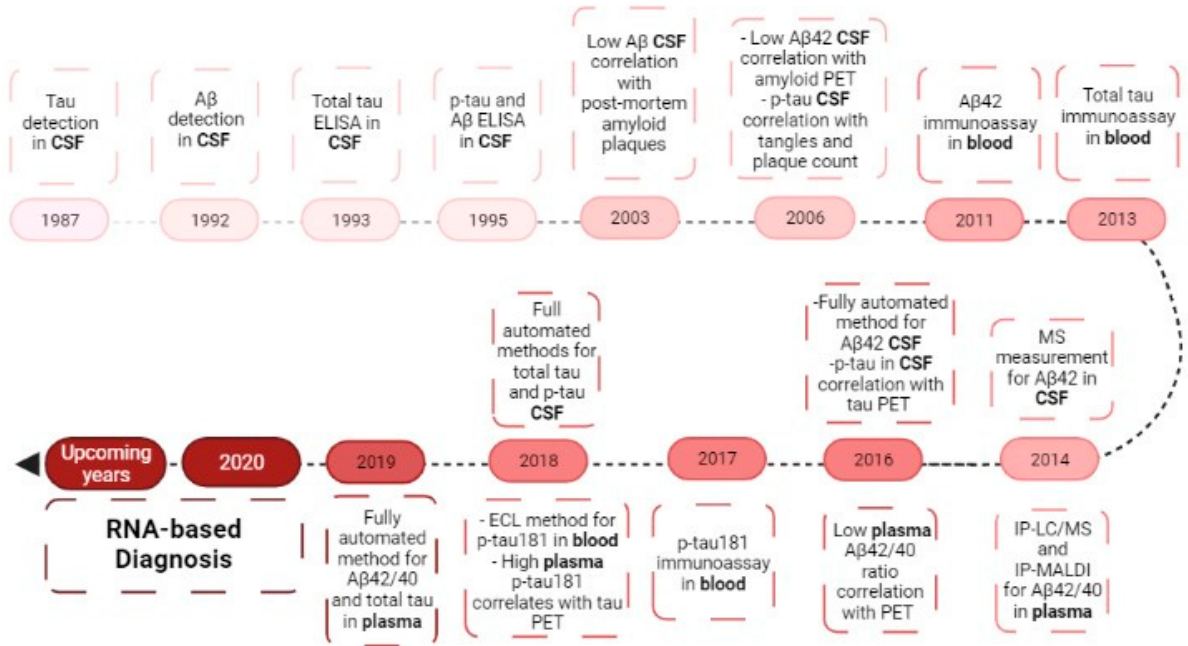
Figure 5. Biomarkers evolution in the diagnosis of Alzheimer’s disease. Evolution from the study of CSF biomarkers to the blood biomarkers, ending in the RNA research of today. CSF—cerebrospinal fluid; A β —amyloid beta-peptide; p-Tau—phosphor-Tau; PET—positron emission tomography; MS—mass spectrometry; IP-LC—immunoprecipitation liquid chromatography-mass spectrometry; IP-MALDI—immunoprecipitation matrix-assisted laser desorption/ionization; ECL—electrochemiluminescence.